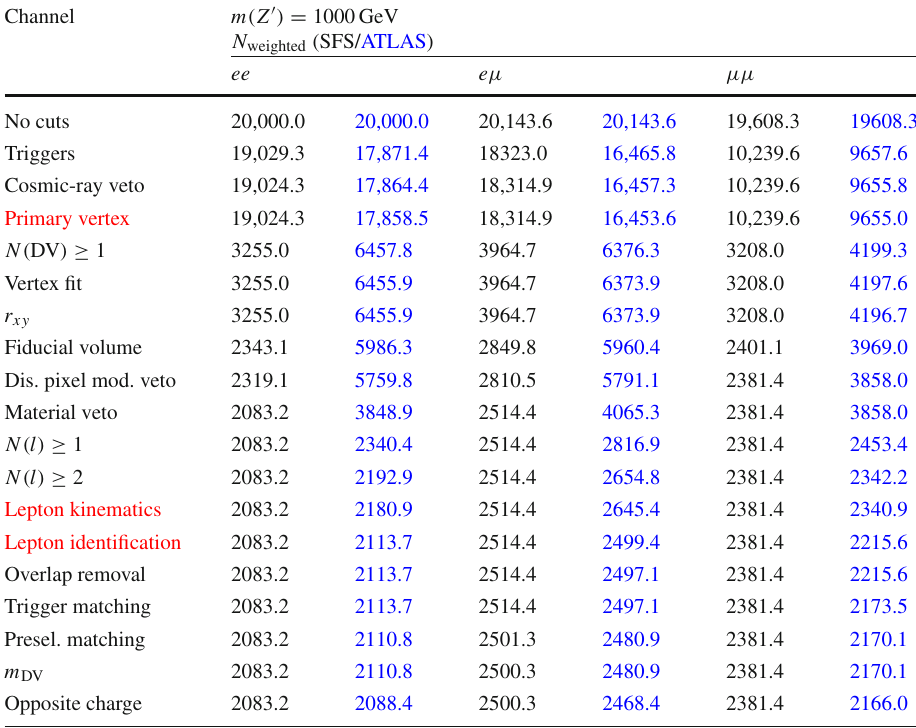
Table 8 Same as Table 7 for a Z (cid:6) mass of 1000GeV